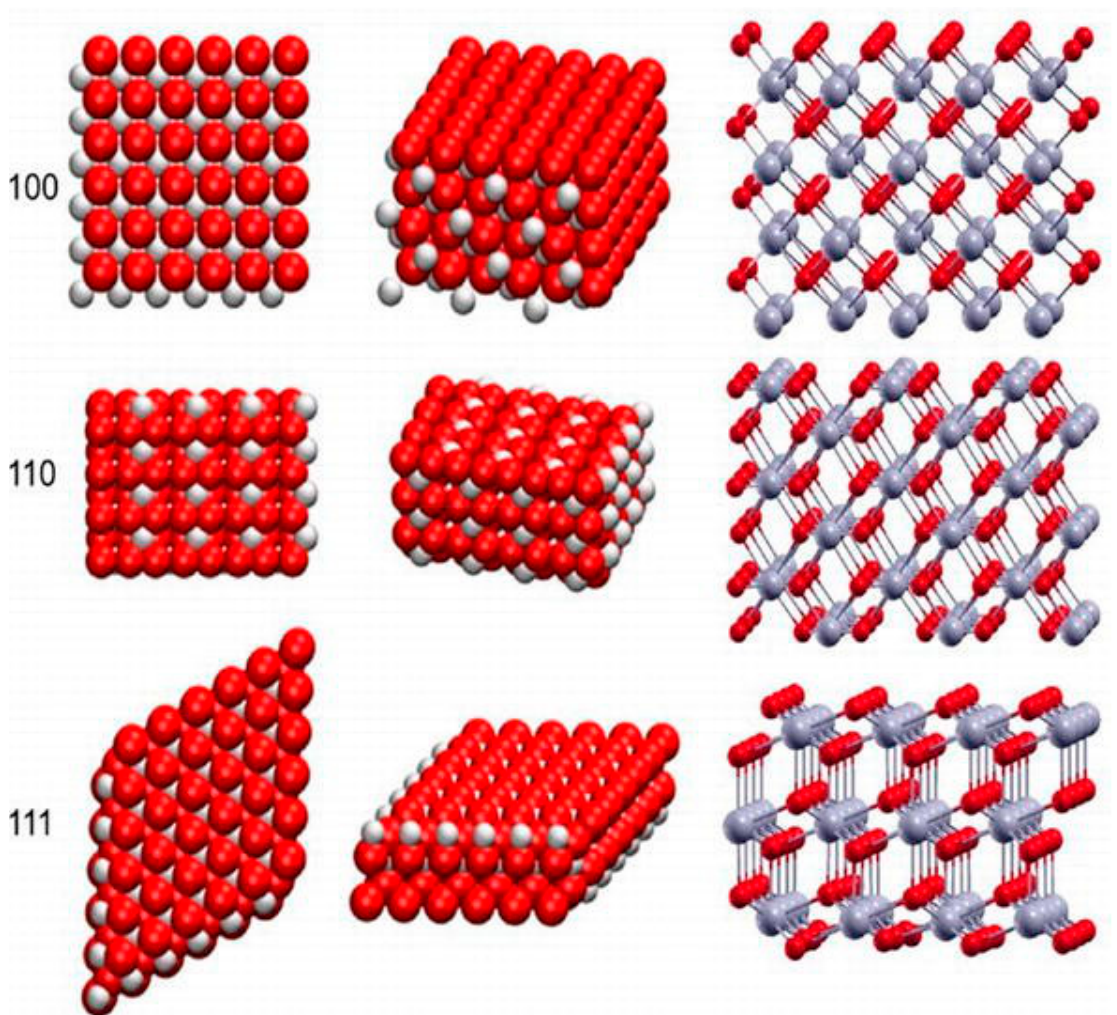
Figure 1. Crystal lattice and (100), (110), and (111) surfaces of cerium oxide nanoparticles [11], used with no changes under the terms of the Creative Commons Attribution 3.0 International License (Creative Commons Attribution 3.0 License).